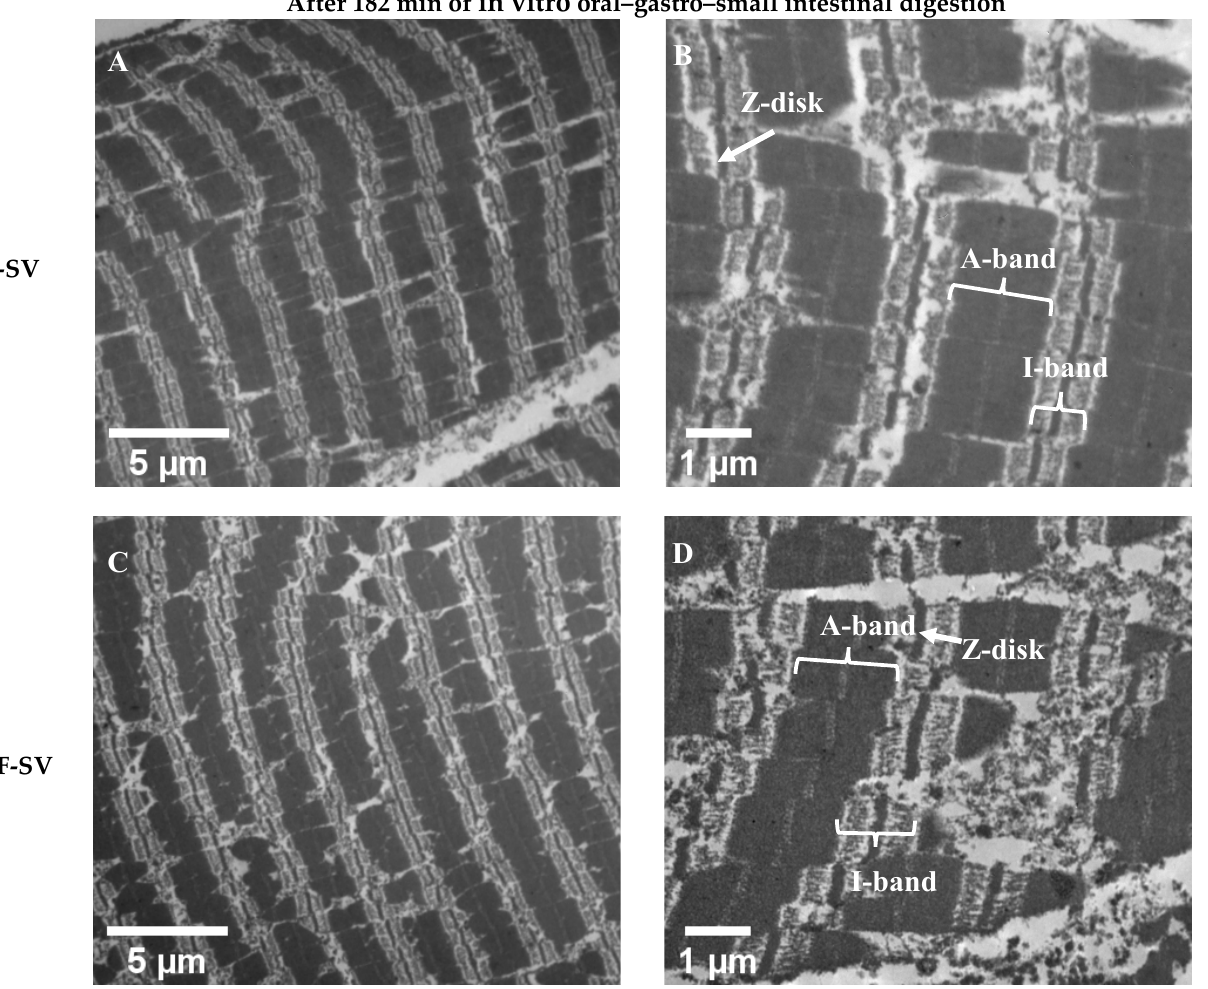
Figure 5. Transmission electron micrographs displaying the ultrastructure of the control ( C ) sous vide (SV)-cooked ( A , B ) and the PEF-treated SV-cooked ( C , D ) beef brisket after 182 min of simulated digestion. The digested PEF-treated SV-cooked meat had more damaged sarcomeres and more coagulated and elongated I-bands, indicating more severe proteolysis by the digestive enzymes .